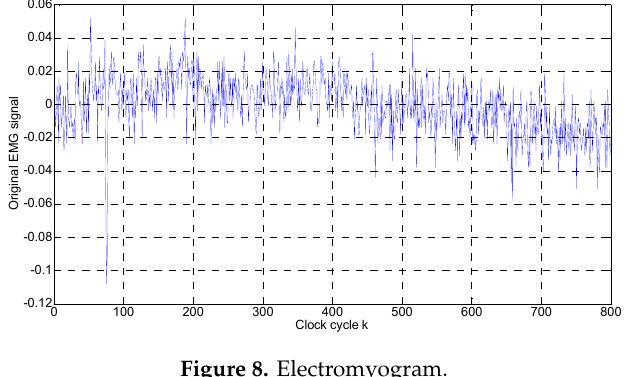
800-0.12-0.1-0.08-0.06-0.04-0.0200.020.040.06 500 600 700 Clock cycle k Appl. Sci. 2020 , 10 , x FOR PEER REVIEW Figure 8. Electromyogram. Figure 8. Electromyogram. Figure 8. Electromyogram.